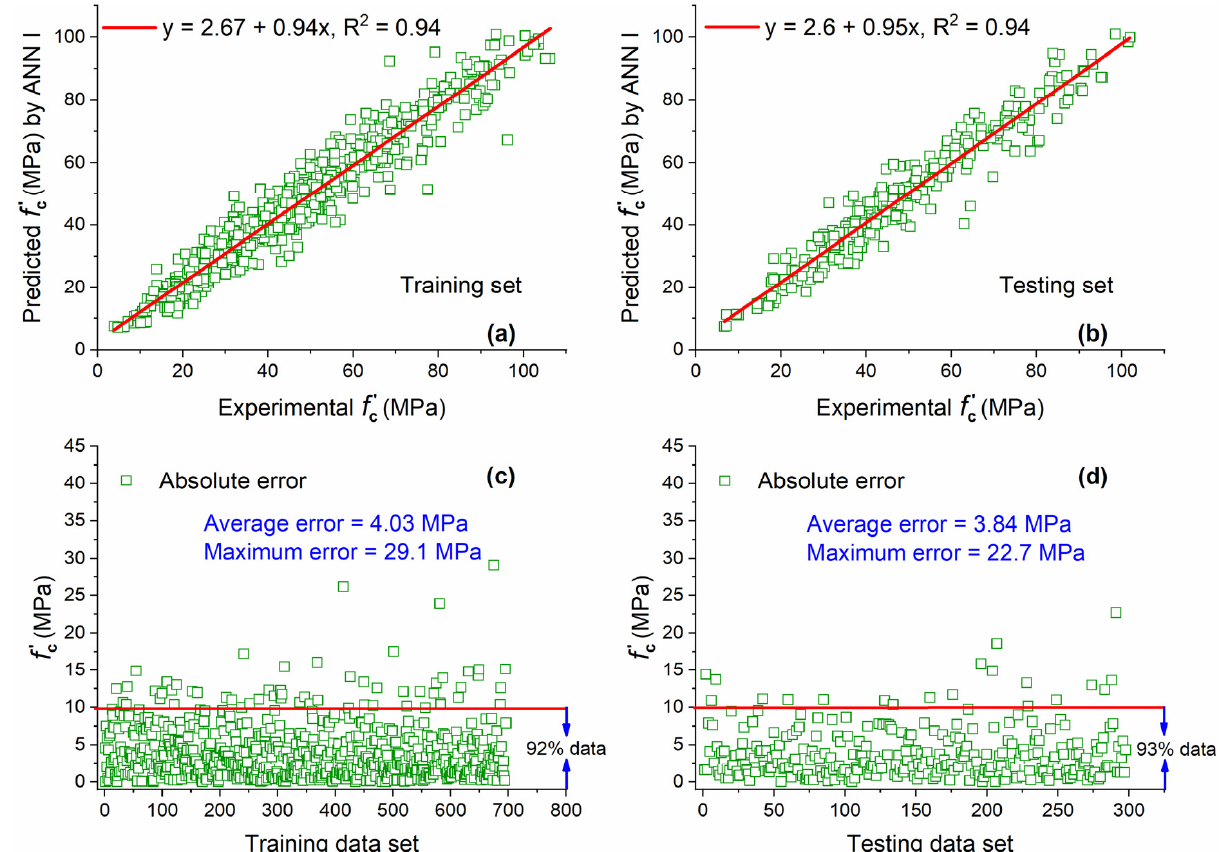
Figure 8. Experimental and predicted values of (cid:1858)′ (cid:2913) by ANN I for ( a ) training set and ( b ) testing set, and their corresponding absolute error for ( c ) training data set and ( d ) testing data set.